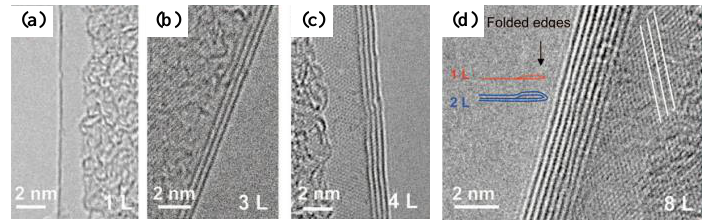
Figure 7. TEM images of graphene films grown on the Ni substrate: ( a ) 1 layer, ( b ) 3 layers, ( c ) 4 layers, ( d ) 8 layers. (Reproduced from [32] with permission; Copyright 2009 American Chemical Society.)